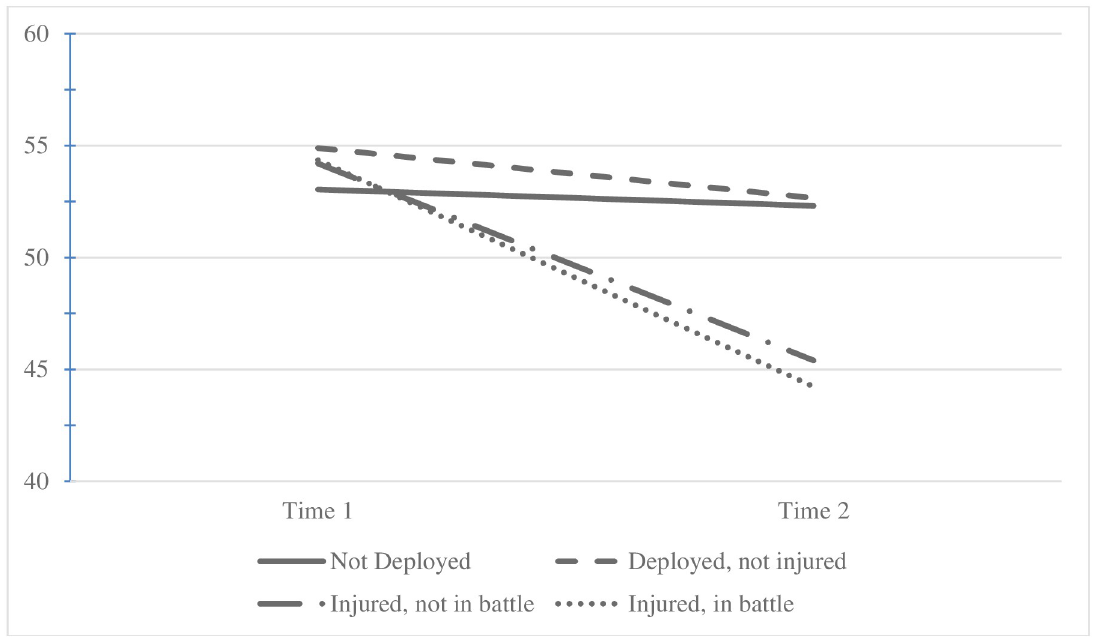
Fig 4. Average Physical Component Summary by deployment and injury status at Time 1 and Time 2. Mean PCS at Time 1 varied by deployment and injury status (mean of 53.0 for ND, 54.9 for DNI, 54.2 for DNBI, and 54.4 for DBI; p-value < .0001; Table 1 and Fig 4) and pairwise comparisons revealed a significant (p-value < 0.05) group difference between ND and DNI’s mean Time 1 PCS. Mean change in PCS between Time 1 and Time 2 varied significantly by deployment and injury status (mean change for ND -0.7, DNI -2.2, DNBI -8.8, and DBI -10.1; p- value < .0001; Table 1 and Fig 4) with significant (p-value < 0.05) group differences found between all groups except the two injured groups. Additionally, mean PCS at Time 2 varied significantly by deployment and injury status (Table 1 and Fig 4) where pairwise comparisons again revealed significant difference (p-value < 0.05) between all groups except between the two injured